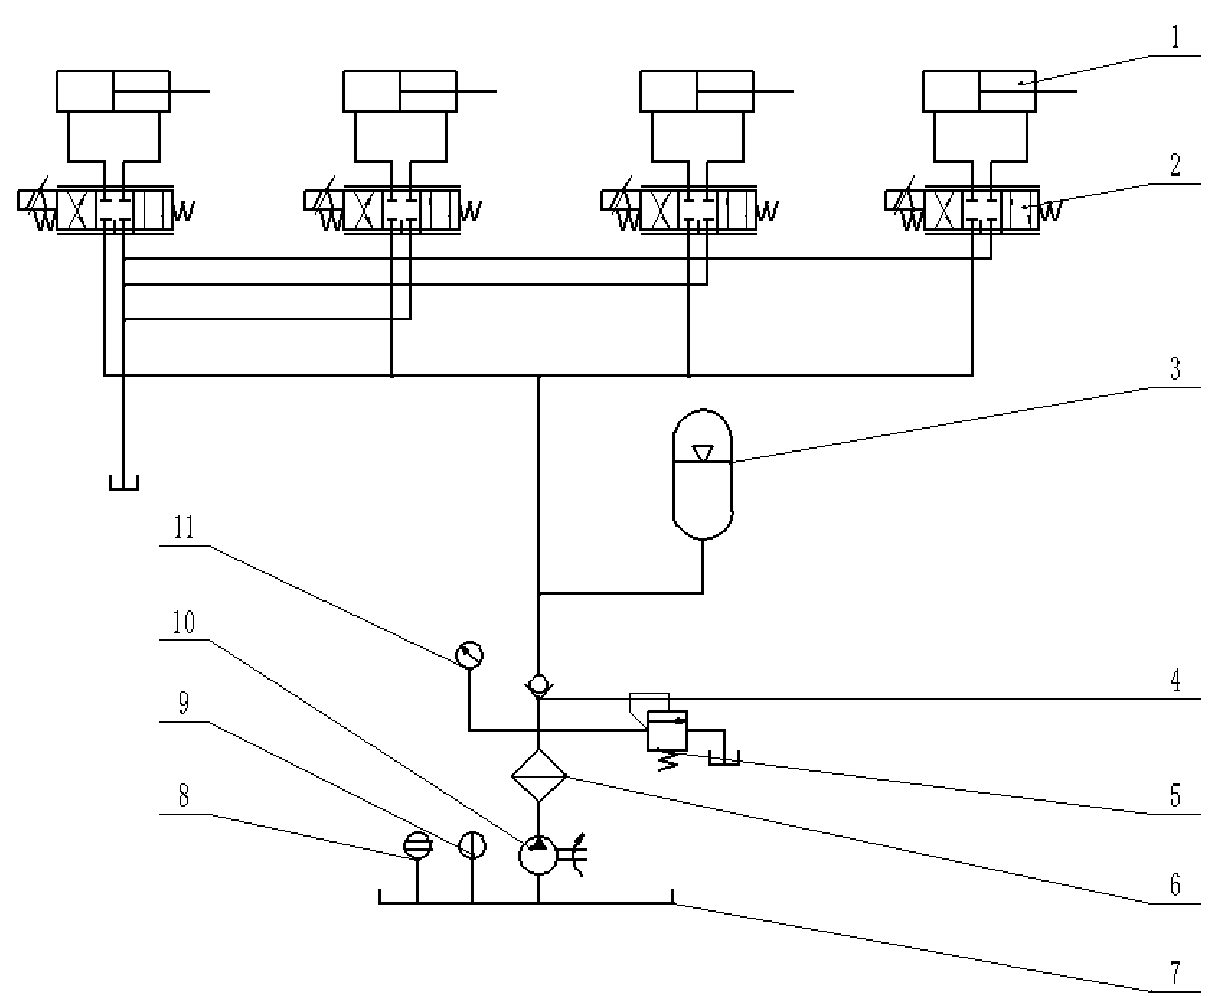
Figure 11. Schematic diagram of the hydraulic system where 1 is hydraulic cylinder, which contains two knee hydraulic cylinders and two hip hydraulic cylinders, 2 is servo valve, 3 is accumulator used to prevent pressure fluctuation, 4 is one-way valve, which prevents the reverse flow of oil, 5 is overflow valve, 6 is filter, 7 is hydraulic tank, 8 is liquid level gauge, 9 is thermometer, 10 is plunger pump, and 11 is pressure gauge. cylinder is 100 mm and that of the knee hydraulic cylinder is 140 mm. The diameter